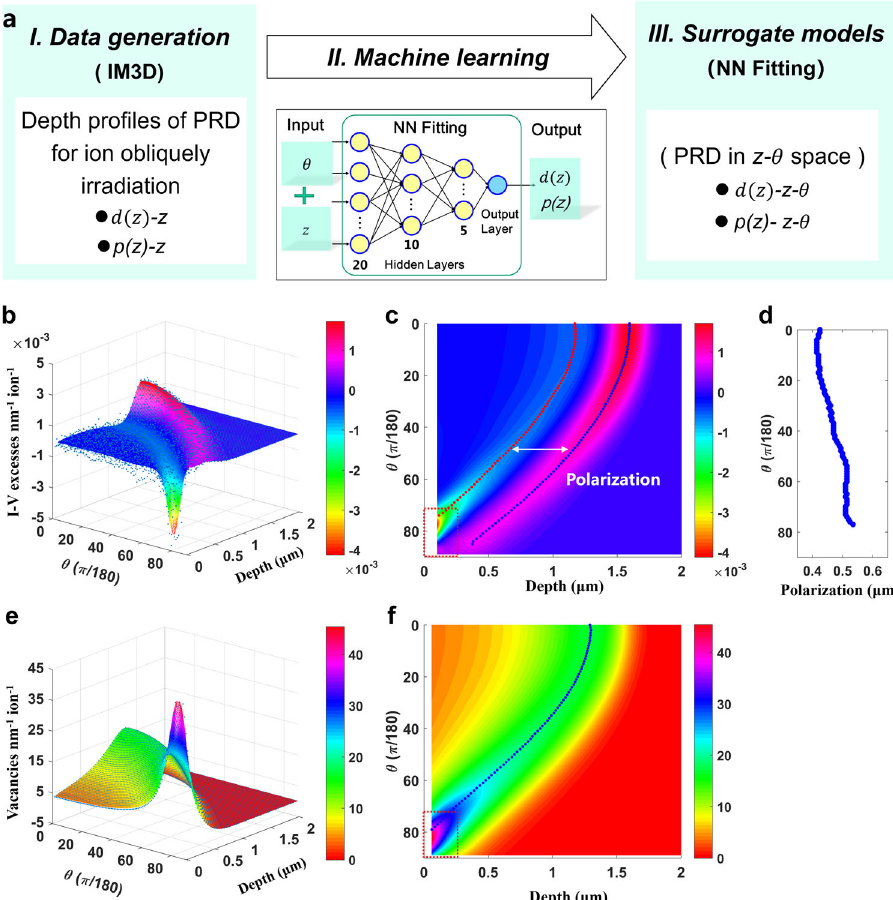
Fig. 4 ML-based surrogate models of I-V excesses and damages as inputs of SSS. a The ML work fl ows with NN fi tting, in which the depth pro fi les of any PRD quantity a z ; E ; θ ð Þ for self-ion irradiation in iron with ion energy of 5 MeV and incident angle θ ¼ 0 :: π IM3D to generate data sets; the ML-based surrogate models of PRDs in depth-momentum space are obtained by NN- fi tting method with PRDs as output and depth-angle as inputs. b Comparison of I-V net excesses between NN-predicted and IM3D-calculated results, identi fi ed as smooth surface and scattered dots, respectively. c The shading plot of NN-predicted I-V excesses in ion depth-momentum space, the centers of mass of de fi ciency x (cid:3) ð Þ and excess x þ ð Þ are identi fi ed by the red and blue dots, respectively. d Angle dependence of the estimated defect polarization. e Comparison of damages between NN-predicted and IM3D-calculated results, identi fi ed as smooth surface and scattered dots, respectively. f The shading plot of NN-predicted damages in depth-momentum space, the peaks of damage are identi fi ed by the blue